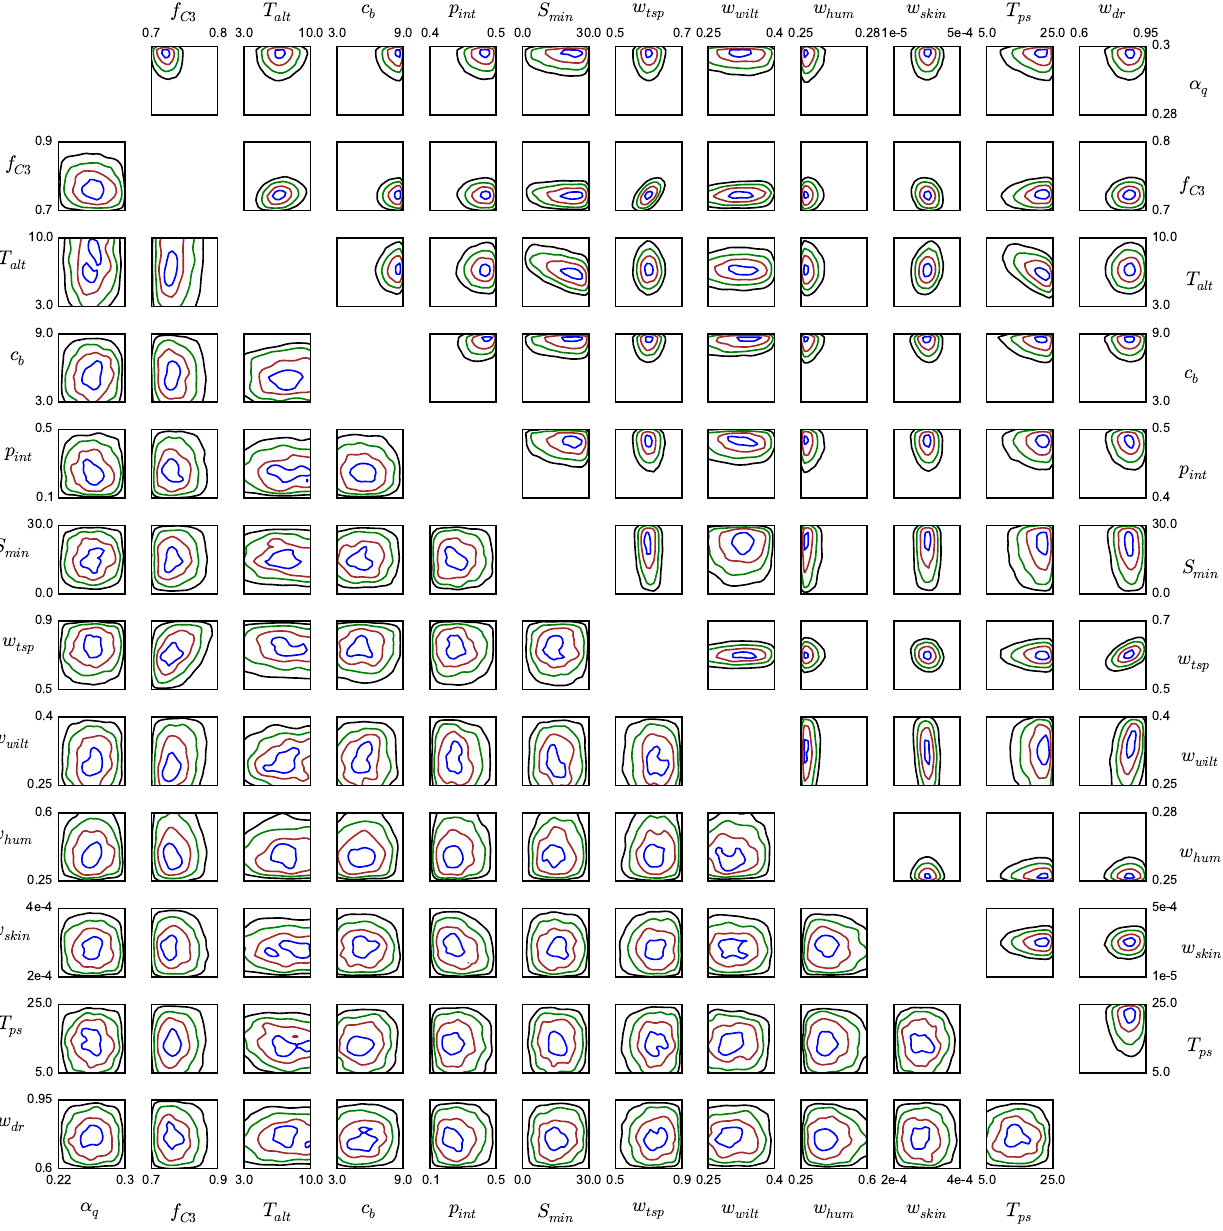
Figure 1. Kernel density estimates of the last 20000 parameter samples with daily (upper triangle) and half-hourly tunings. The contours correspond to densities in a two-dimensional Gaussian distribution ( µ x , µ y = 0, σ x , σ y = 1) with 2 σ (black), 1.5 σ (green), σ (brown), 0.5 σ